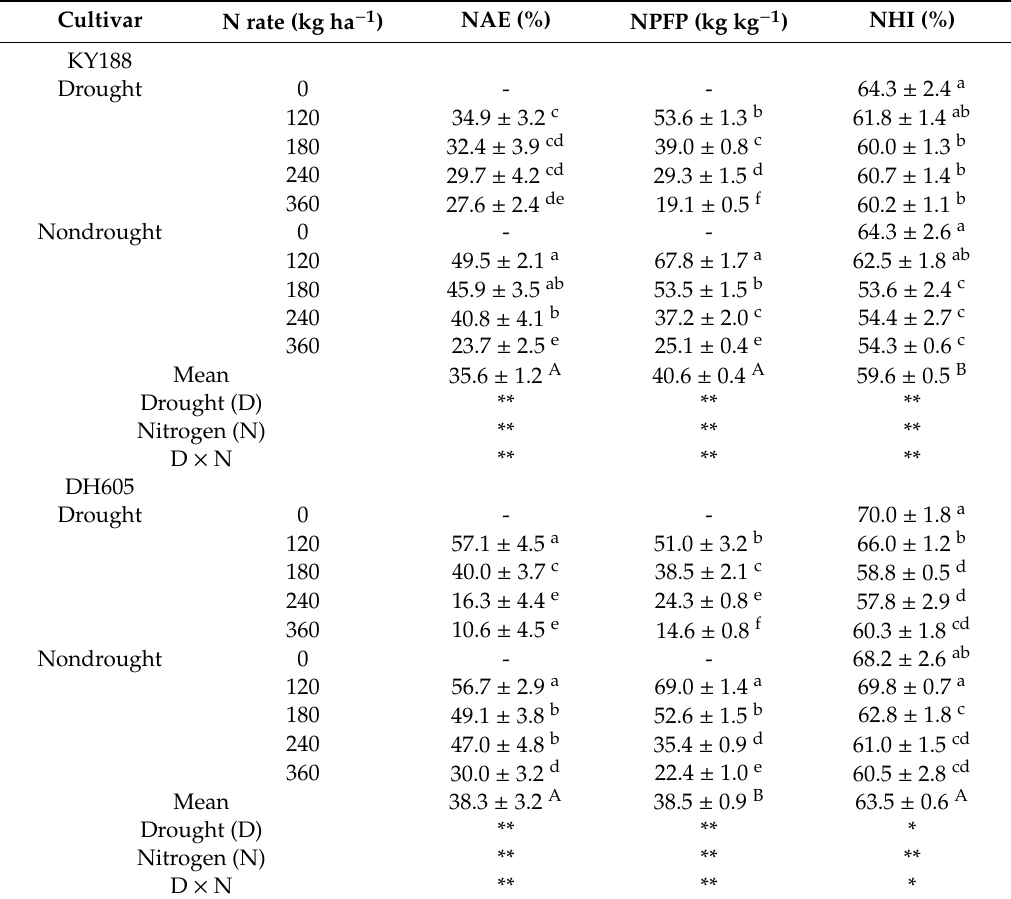
Table 2. N use e ffi ciency of maize grown under di ff erent N levels subjected to drought and nondrought